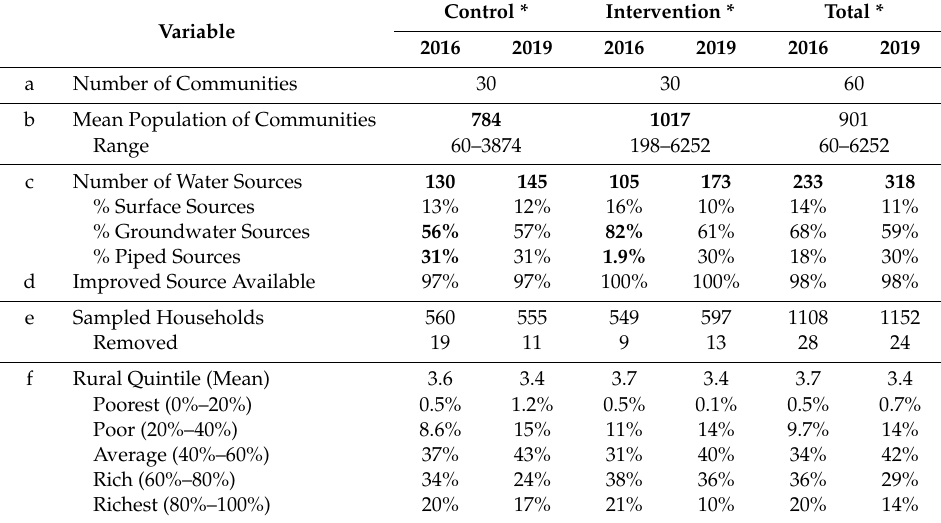
Table 2. Temporal demographics of control and intervention